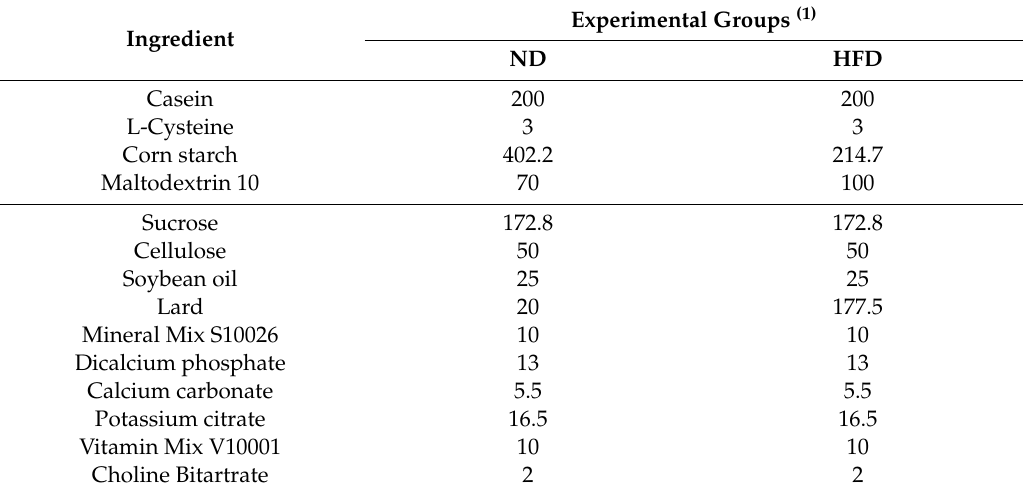
Table 1. Composition of experimental diets (g / kg